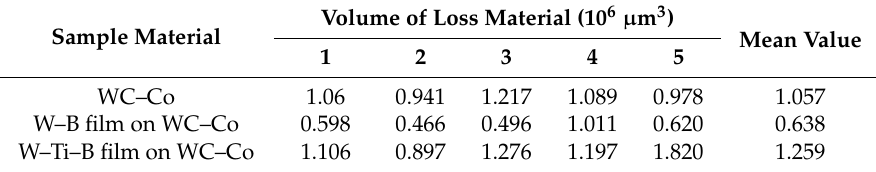
Table 5. Volume of loss material after wear tests.